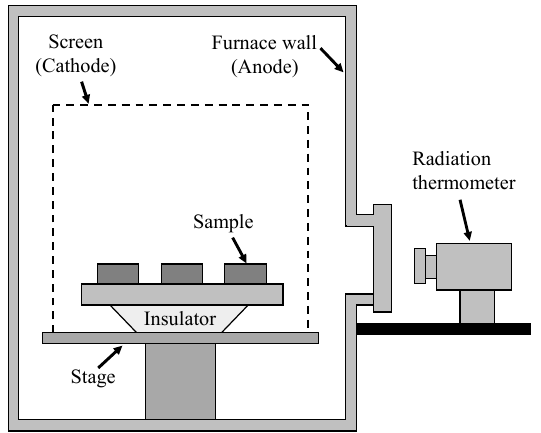
Figure 1. Schematic of device used for active screen plasma nitriding (ASPN) treatment. In the Suga-type abrasive wear test, the abrasion wheel with SiC emery paper #600 rotated against the reciprocating sample surface under a load of 6.4 N. When the